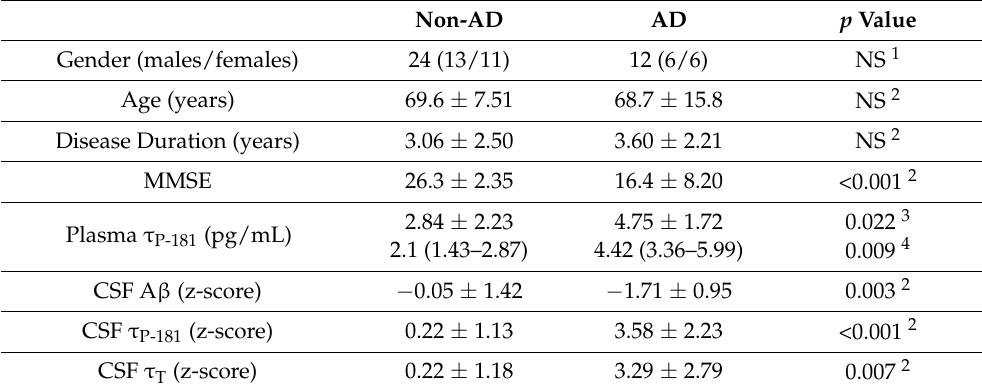
Results are presented as mean ± standard deviation. For plasma which follows the log-normal distribution, median values (25th–75th percentiles are also shown) AD: Alzheimer’s Disease, MMSE: Mini Mental State Examination, CSF: Cerebrospinal fluid, A β : either A β 42 /A β 40 or A β 42 alone (when A β 40 was not available), τ P-181 : tau protein phosphorylated at a threonine residue at position 181, τ T : total tau protein, NS: non-significant. 1 χ 2 -test, 2 t -test, 3 2-way-ANCOVA with diagnostic group and sex as cofactors and age, disease duration